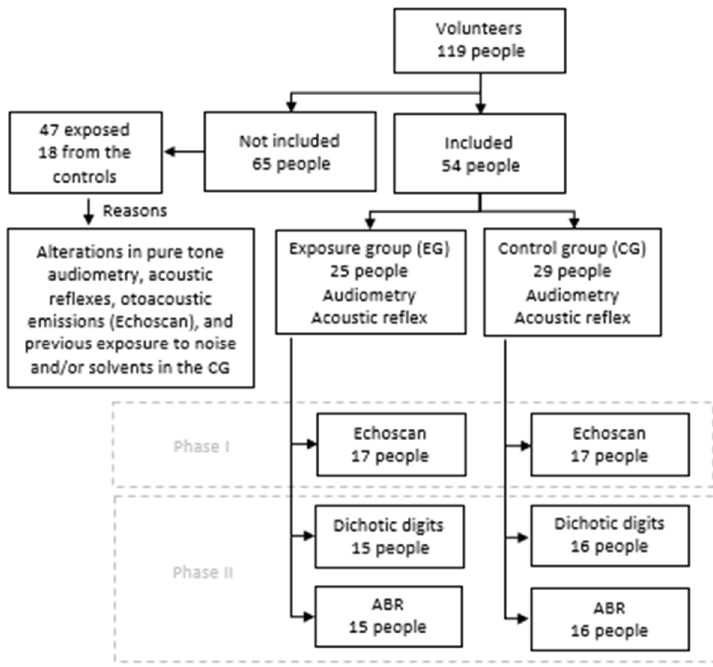
Figure 2. Flowchart of study participants.